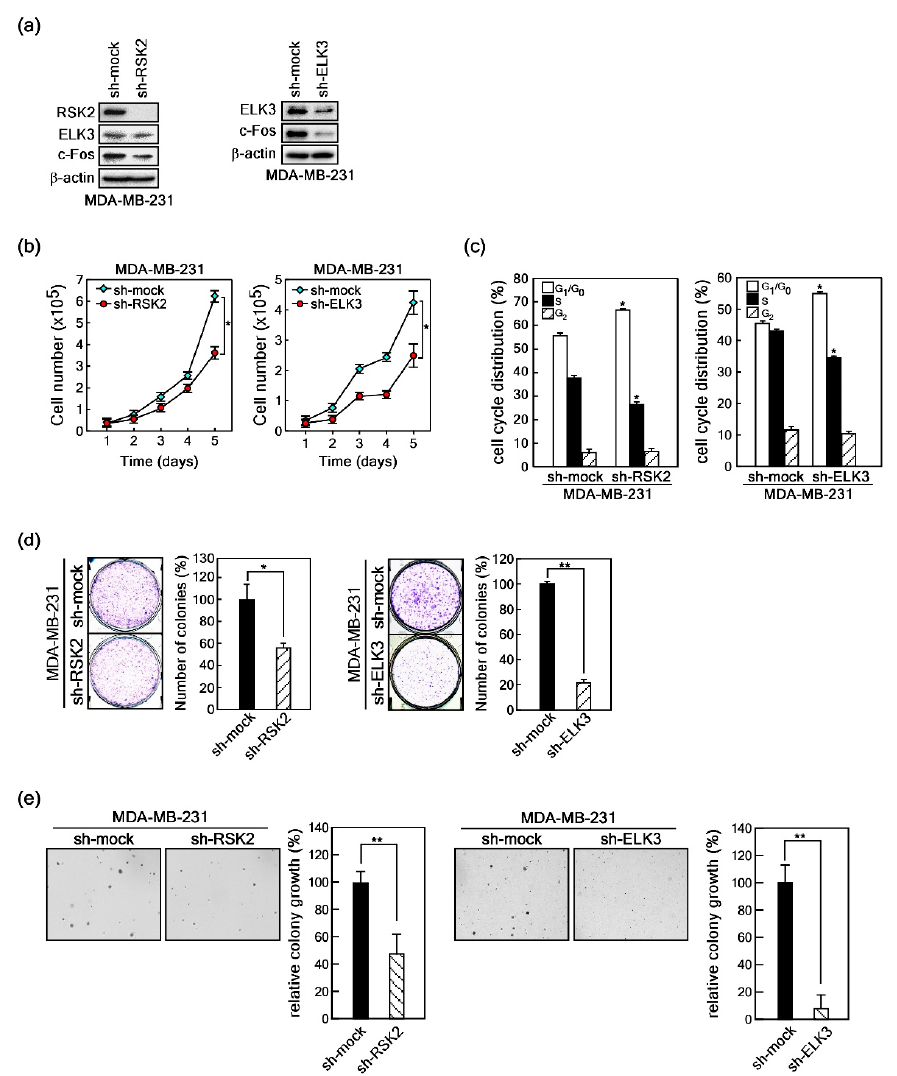
Figure 5. RSK2 and ELK3 are required for MDA-MB-231 cell growth. ( a ) The sh-mock, sh-RSK2 or sh-ELK3 viral particles were separately infected into MDA-MB-231 cells and the puromycin resistance cells were pooled. RSK2 and ELK3 knockdowns were confirmed by western blotting using specific antibodies as indicated. ( b ) Knockdowns of RSK2 or ELK3 inhibit cell proliferation of MDA-MB-231 cells. MDA-MB-231 cells stably expressing sh-RSK2 or sh-ELK3 underwent cell proliferation for 5 days, and cell proliferation was monitored by counting cells using an automated cell counter. ( c ) Knockdowns of RSK2 or ELK3 induce G1/G0 cell-cycle accumulation in MDA-MB-231 cells. MDA-